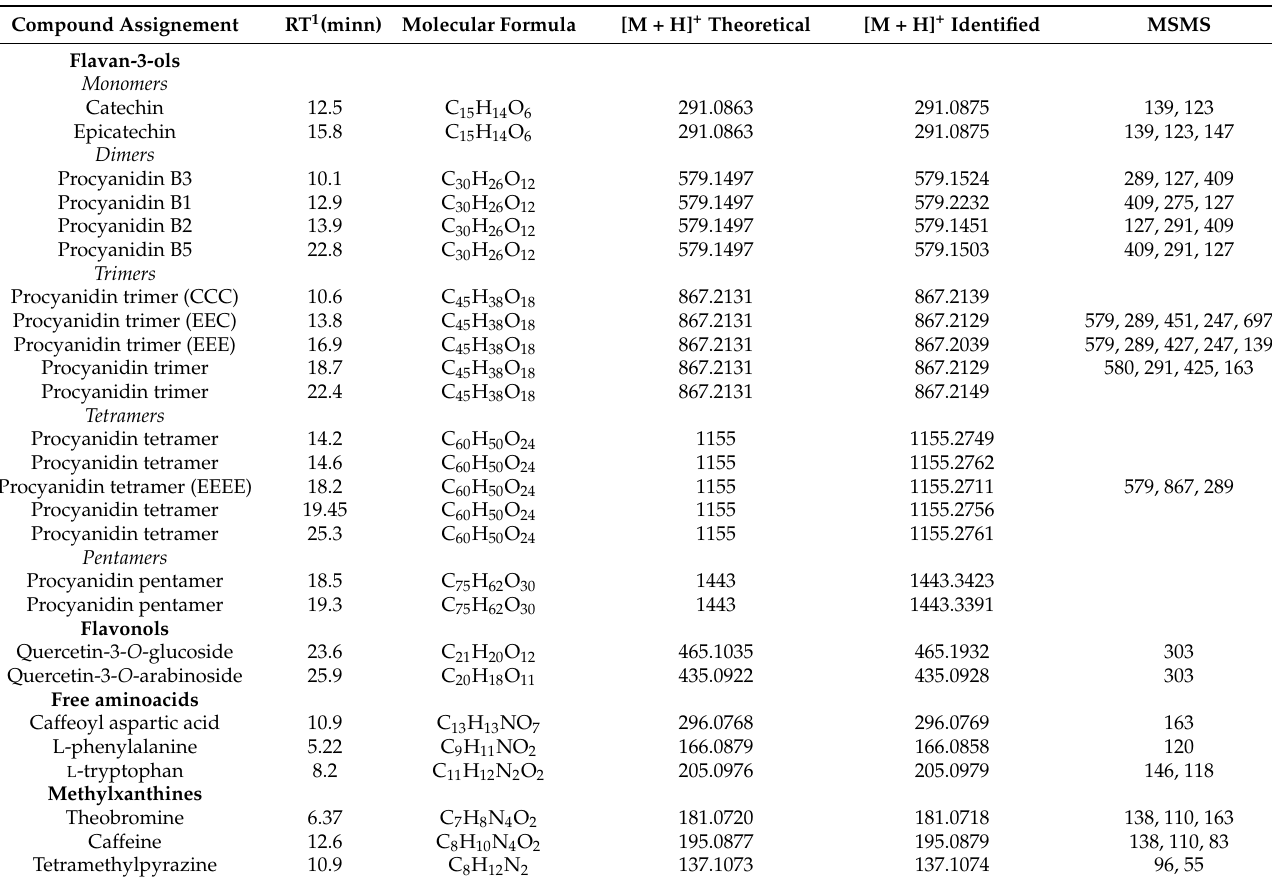
Table 1. Chemical characterization of cocoa